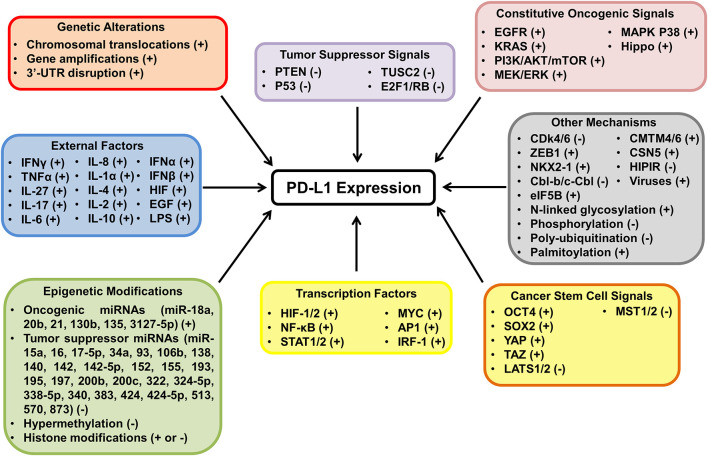
The mechanisms of PD-L1 activation and inactivation in cancer. The diagram highlights the many mechanisms behind PD-L1 regulation in tumor cells and whether the proposed mechanisms have been shown to upregulate (+) or downregulate (−) the expression of PD-L1. PD-L1 expression is regulated at the transcriptional, post transcriptional, translational, and post translational level in tumor cells. Many mechanisms have been shown to modulate PD-L1 expression including genetic aberrations, epigenetic modifications, oncogenic and tumor suppressor signals and extrinsic factors.